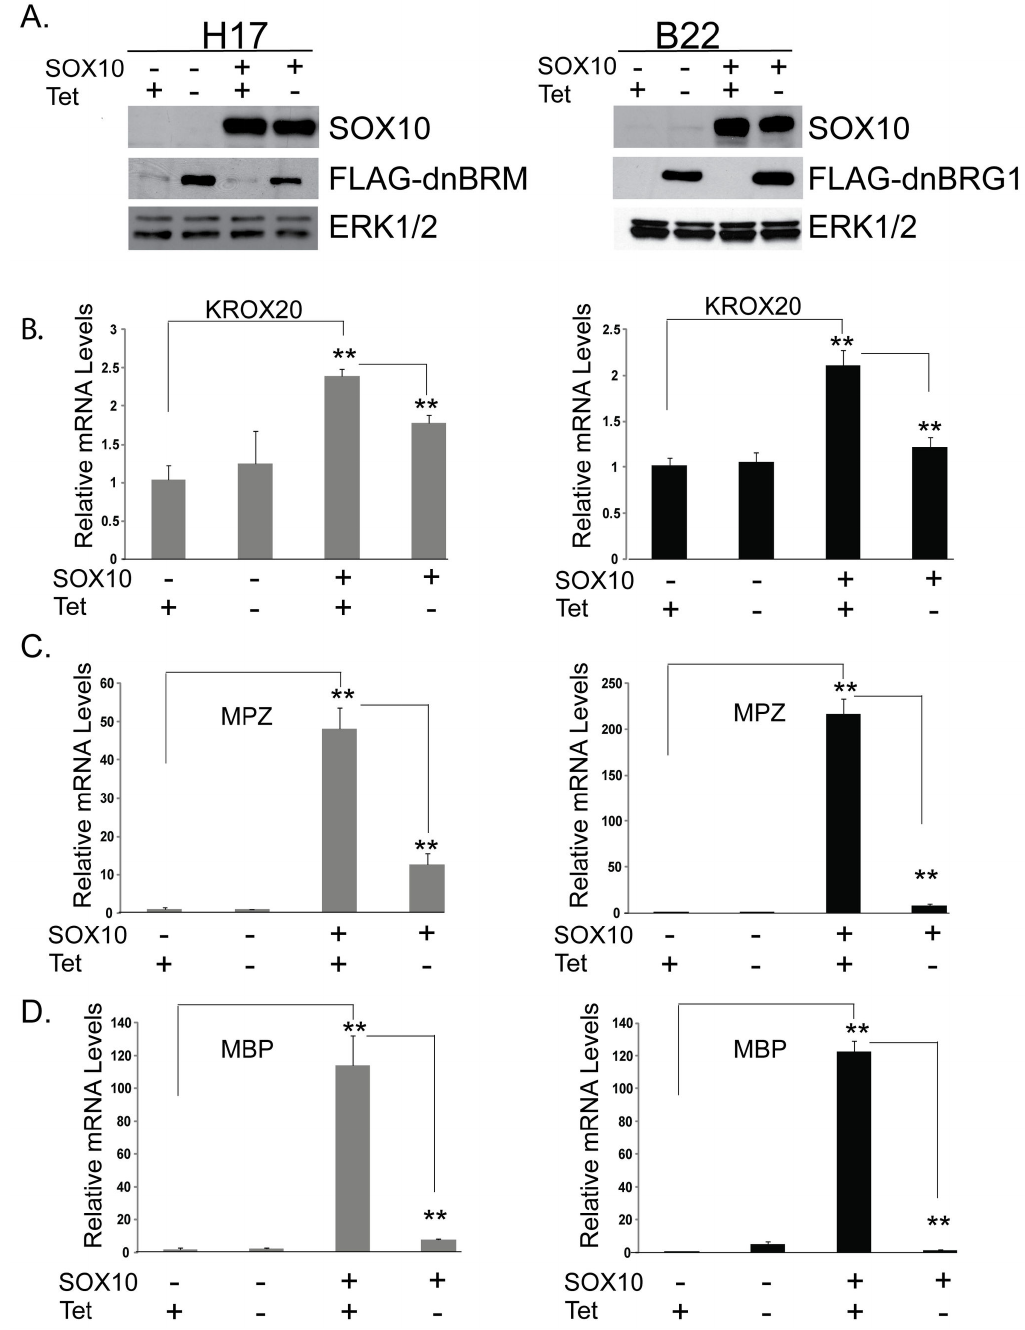
Figure 1. Dominant negative BRM and BRG1 inhibit SOX10-mediated activation of myelin genes. Cell lines that express dominant negative BRM or BRG1 were either infected with a pBabe control vector or pBabe-SOX10 in the presence or absence of tetracycline and then cultured in low serum media to promote differentiation. (A) Western Blot showing expression of SOX10 in cells that were cultured in the presence and absence of tetracycline and the expression of FLAG-tagged dominant negative BRM (left) in the H17 cell line and BRG1 (right) in the B22 cell line, when cells were cultured in the absence of tetracycline. Protein expression was detected from cell extracts and ERK1/2 was used as a loading control (B) Quantitative RT-PCR (qRT-PCR) of SOX10 target genes from pBabe or pBabe-SOX10 infected H17 (left) and B22 (right) cells. KROX20, MPZ, and MBP expression was normalized to expression of RPL7. The data are representative of at least four experiments and are the average of two independent experiments performed in triplicate. Standard error bars and statistical significance are shown (**p<0.01). doi: 10.1371/journal.pone.0069037.g001 PLOS ONE |